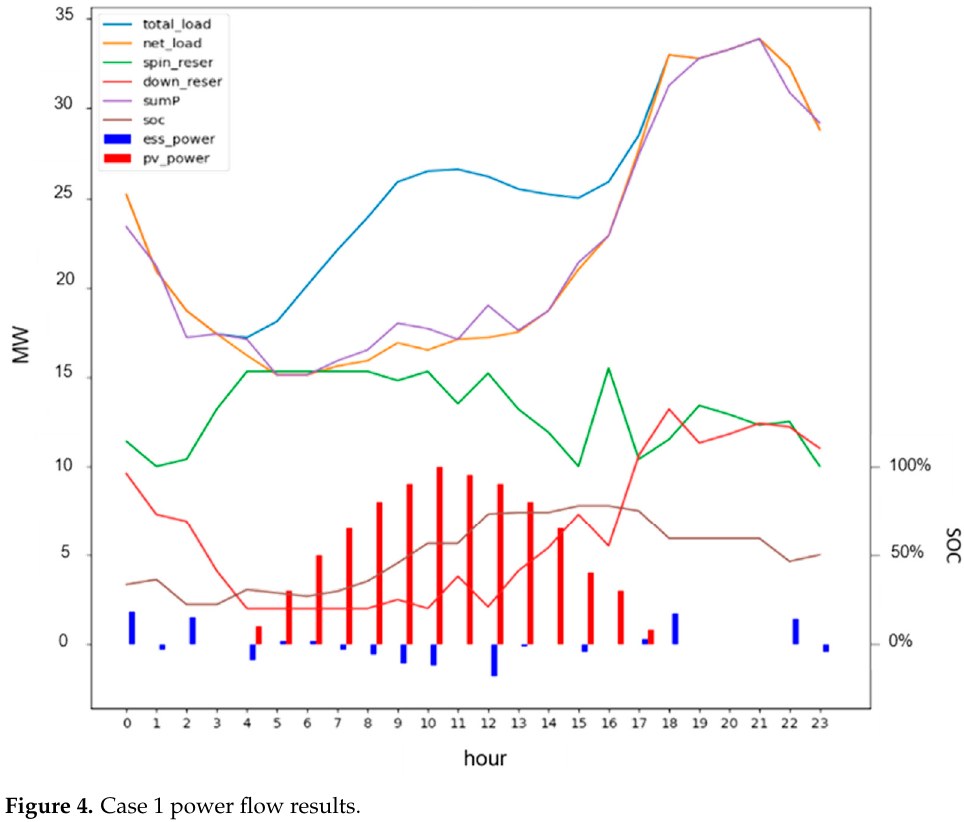
Figure 4. Case 1 power flow results.